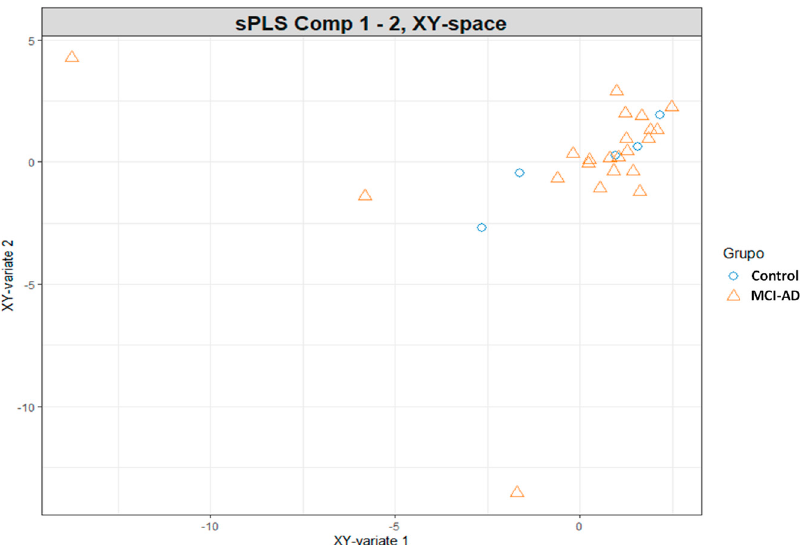
Figure 1. Scatter plot for participants samples in sPLS analysis. Represent the samples distribution in the ‘common’ subspace between the two sets of components (epigenomics and lipidomics variables).